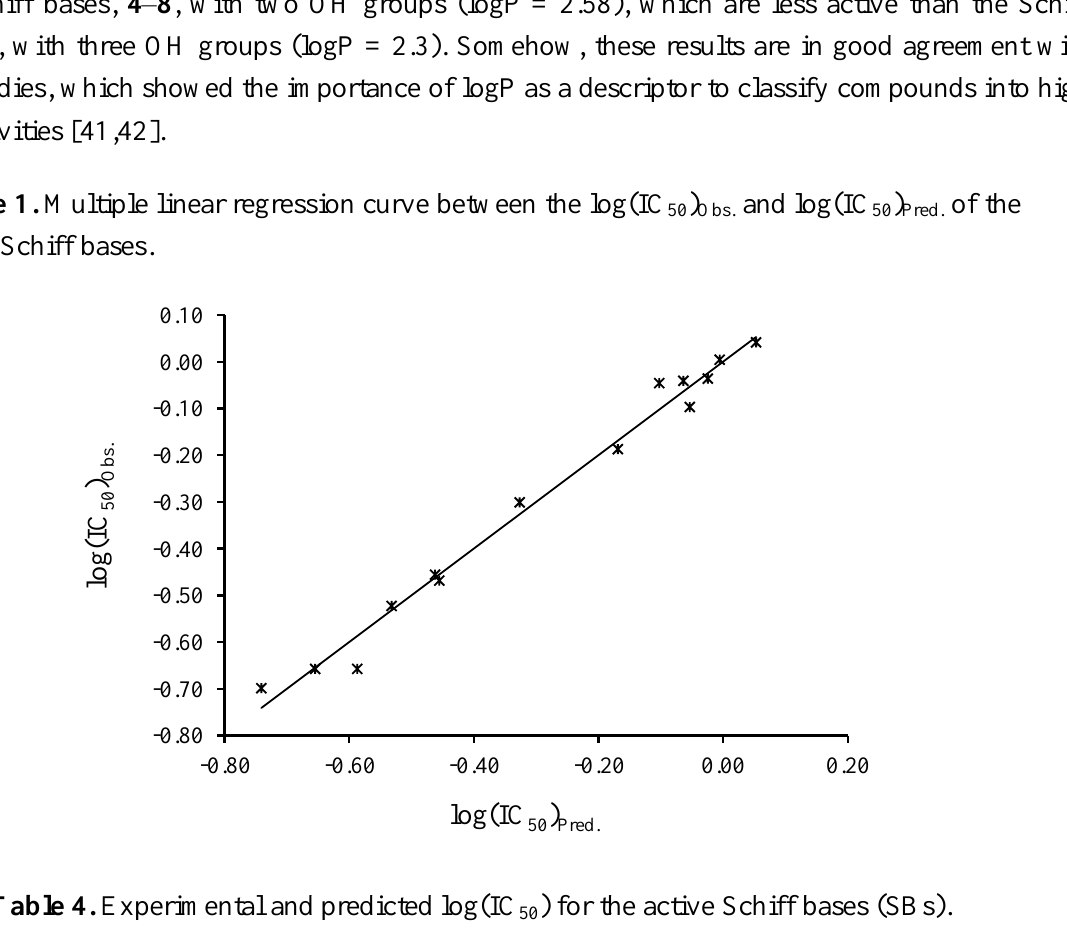
Table 4. Experimental and predicted log(IC SBs log(IC ) 50